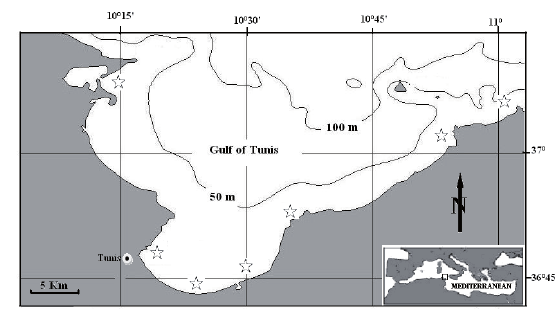
Fig . 1. – map of the Gulf of tunis showing the study area of P. acarne . ( ): sampling